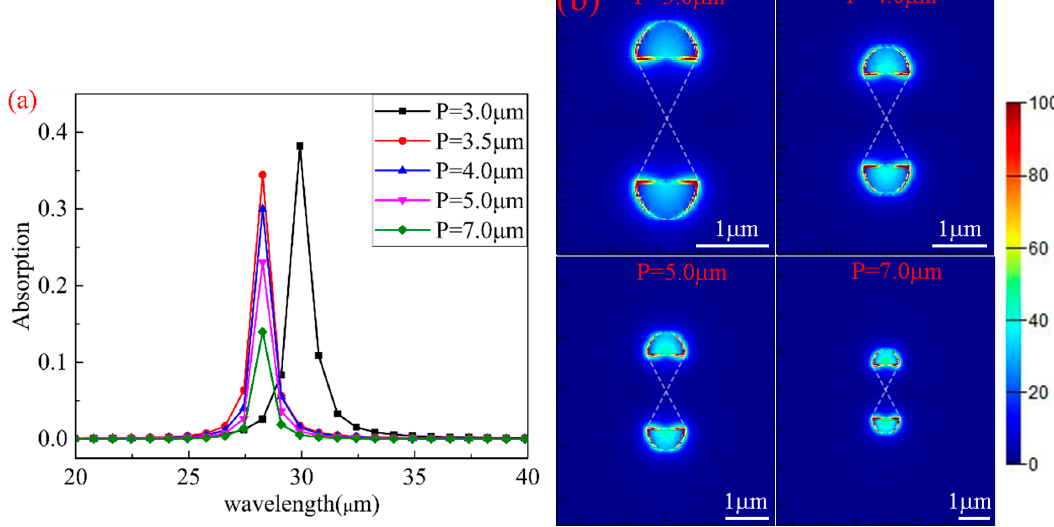
Figure 6. ( a ) The absorption spectra of the structure with different P values. ( b ) The electric field distributions at the absorption peak for P = 3.0,4.0,5.0,7.0 µ